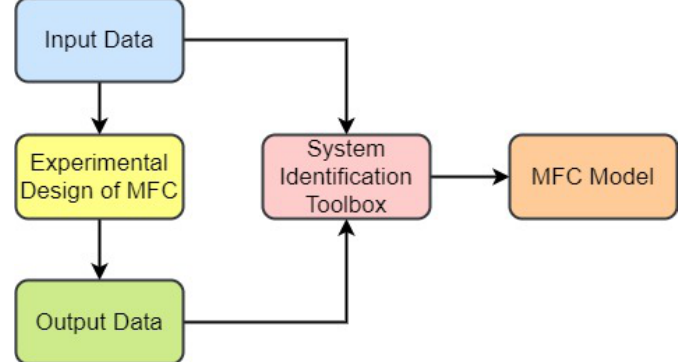
Figure 7. MFC Modeling using a System Identification